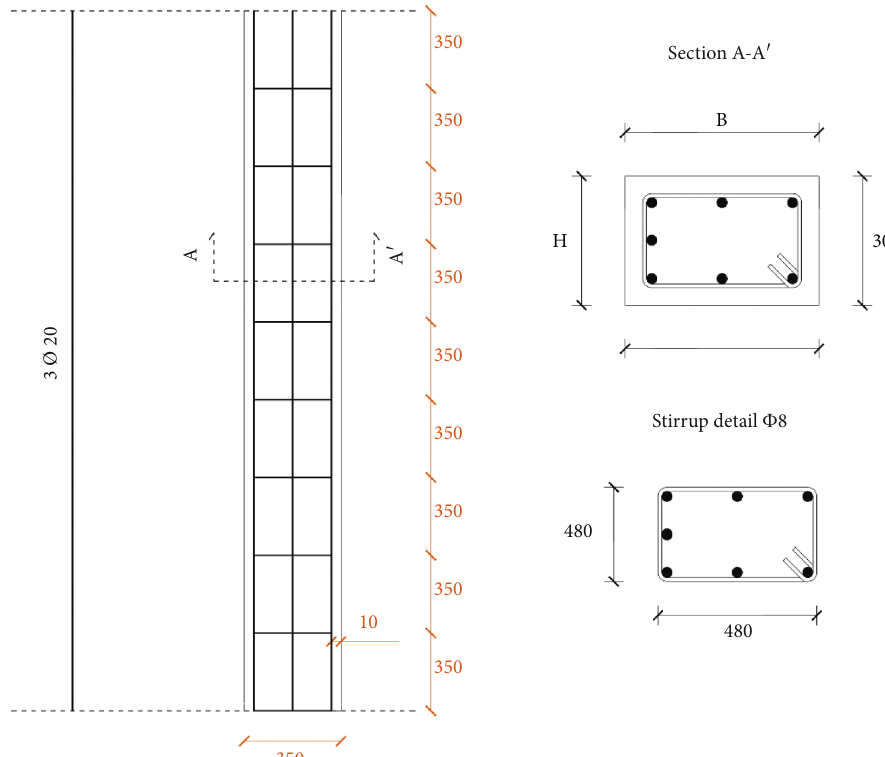
Figure 5: Identification of internal reinforcing bars of the column: cross section (a) and longitudinal section (b).